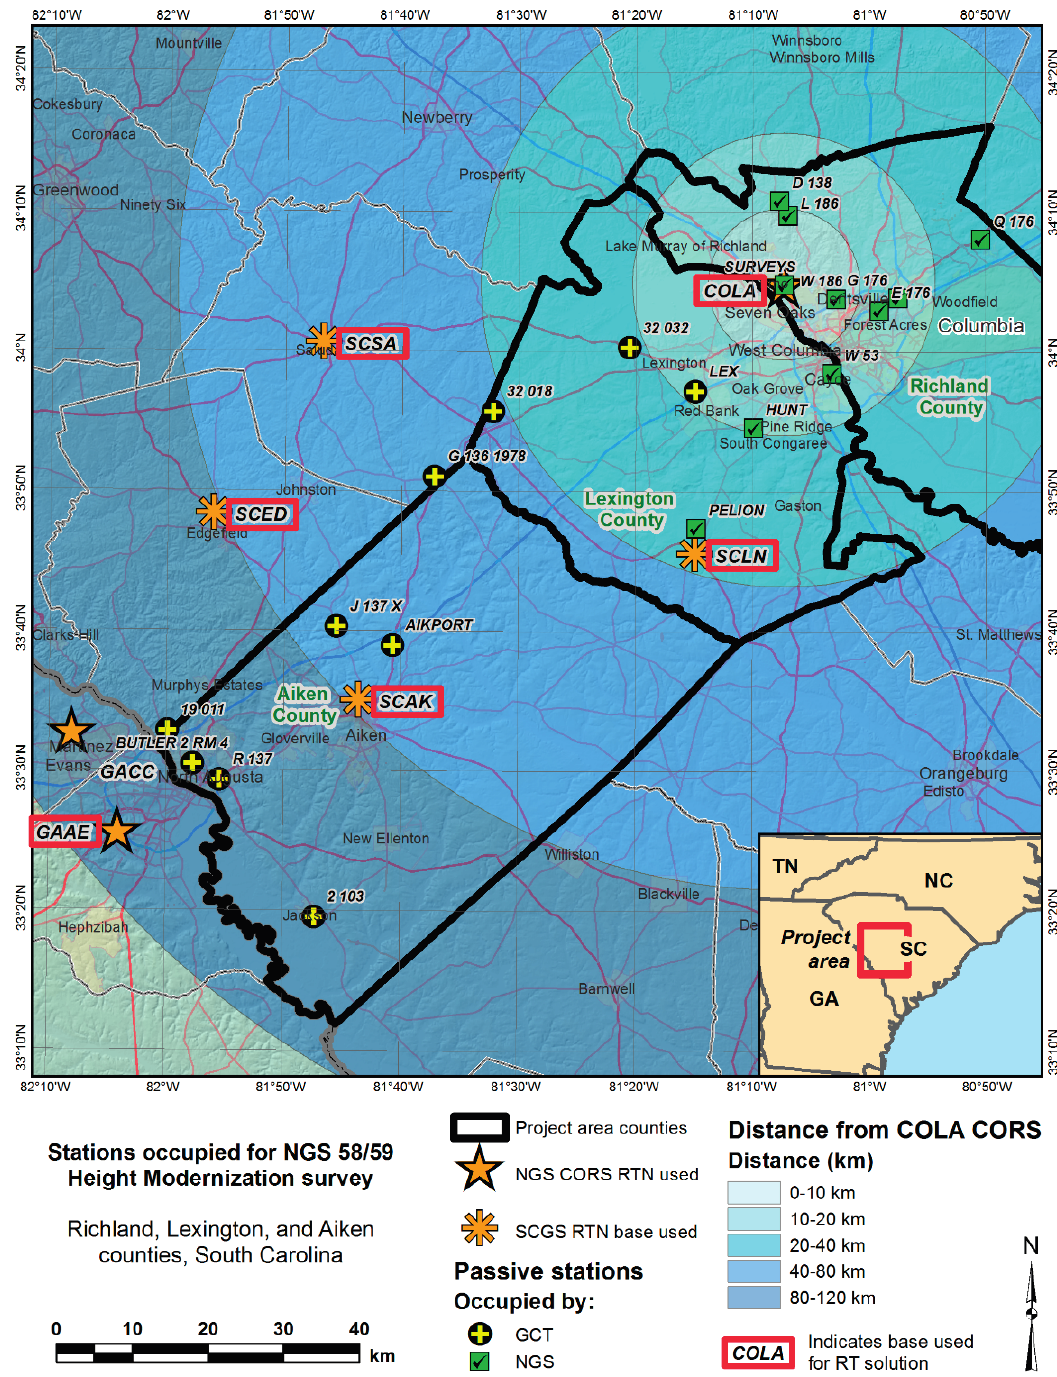
Figure 2. Study area for Phase 2